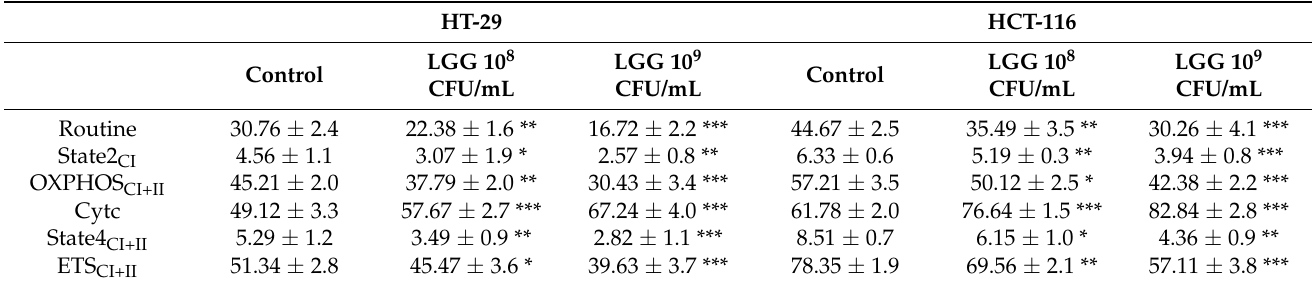
Table 2. Mitochondrial respiratory rates of HT-29 and HCT-116 cells treated with LGG (10 8 and 10 9